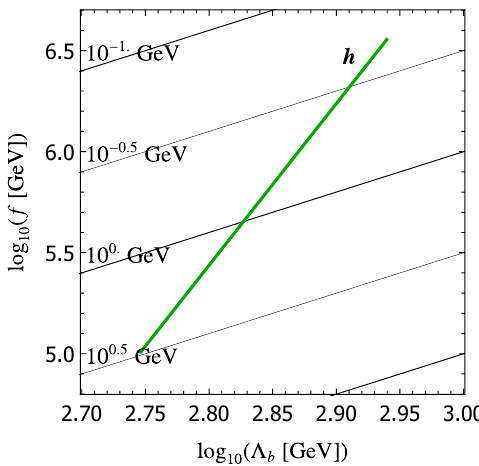
Figure 30 . Contours of m (cid:30) , as de(cid:12)ned in eq. (3.11), in the allowed range of f and (cid:3) b for e